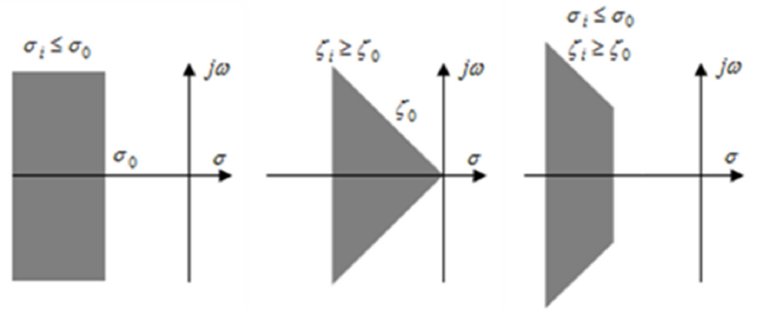
Figure 9. Regions relevant to J 1 , J 2 and J (D-shape area in the s-plane).